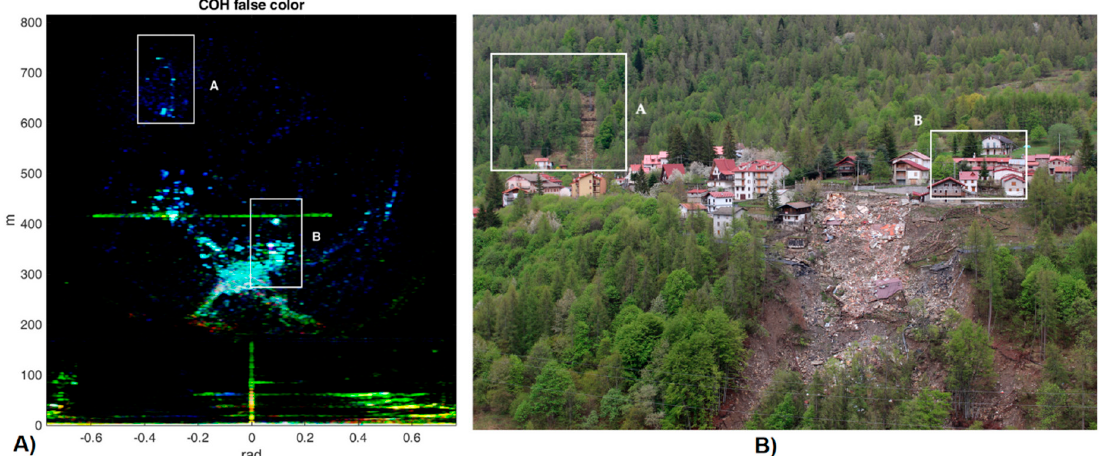
Figure 16. ( A ) Coherence false colour map with two specific indicated areas, A and B. ( B ) Picture of the monitored areas with the corresponding A and B sectors indicated.